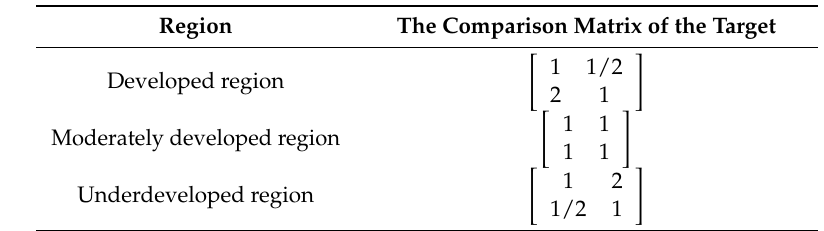
Table 17. The comparison matrix of the target of di ff erent region.